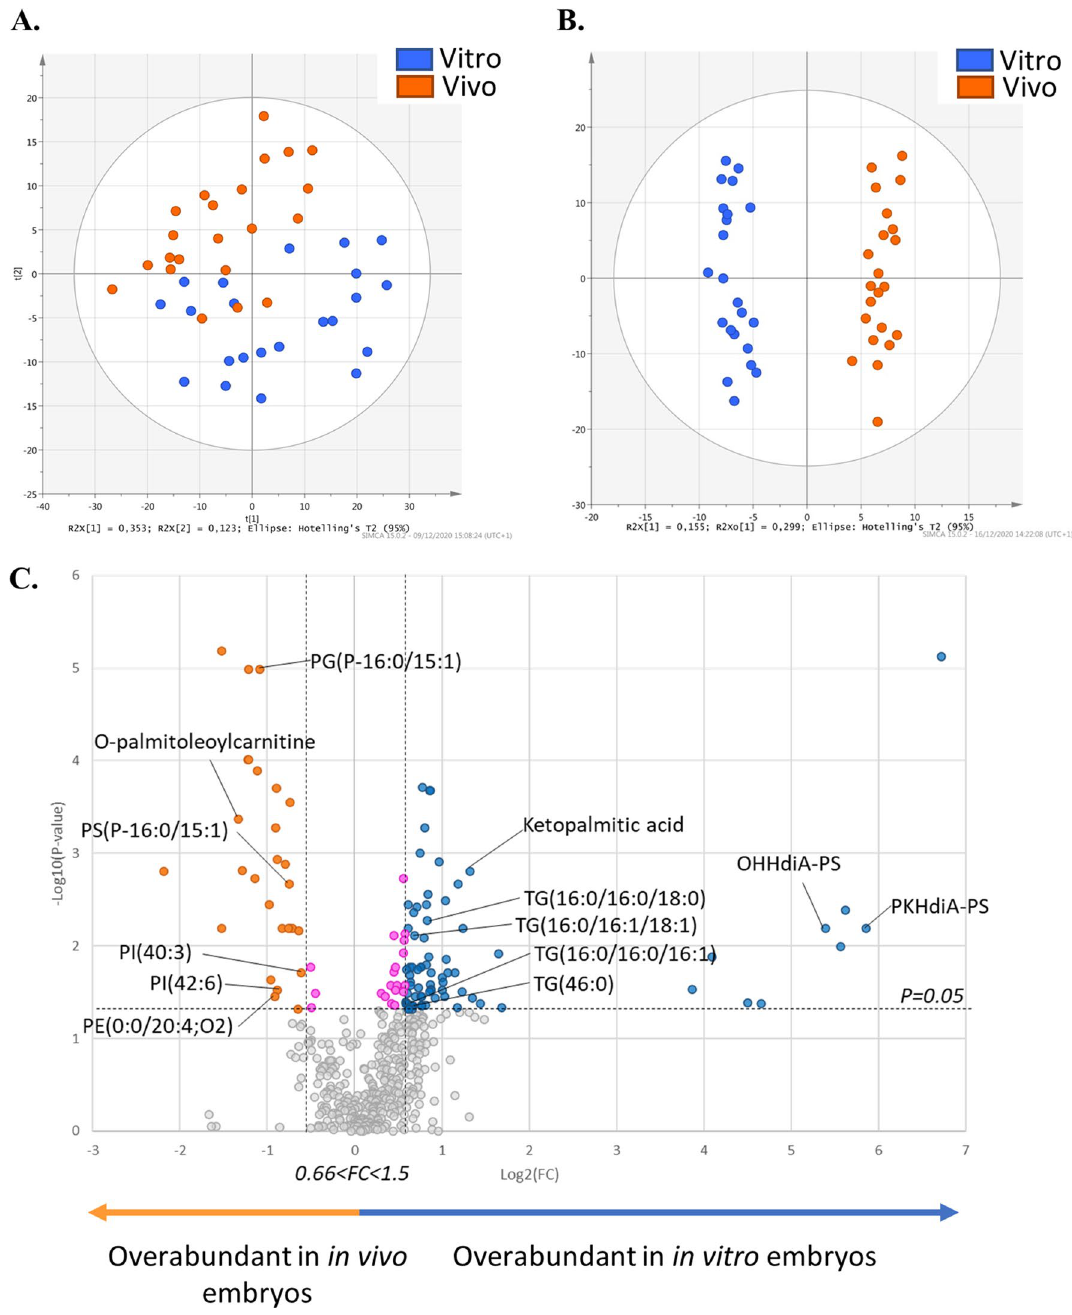
Figure 2. ( A ) Principal component analysis plot (PCA) representing variance among in vivo and in vitro embryos according to principal component analysis. The orange dots show data for embryos with in vivo origin, and the blue dots show data for embryos with in vitro origin. ( B ) Multivariate analysis by orthogonal partial least square discriminant analysis (O-PLS-DA), discriminating the embryonic origins ( vivo vs. vitro ) according to the lipid profile of the embryos. ( C ) Univariate analysis by volcano plot based on fold-change and p value, highlight several lipids. Blue and orange dots correspond to significantly different lipids between in vitro and in vivo produced embryos. The grey dots represent the non-significant ones. Pink dots correspond to lipids with a significant p value but a fold-change between 0.66 and 1.5. All the lipids to the right of this area are over abundant in the in vitro produced embryos (blue dots), while those that are to the left of this area are over abundant in the in vivo produced embryos (orange dots). Statistical significance is determined at p < 0.05 and fold-change greater than 1.5 or less than 0.66. Significantly different annotated lipids are represented on the volcano plot by the following abbreviations, phosphatidyl-ethanolamine (PE), inositol (PI), serine (PS), glycerol (PG), triglycerides (TG) and oxidised glycerophospholipid (OHHdia-PS and